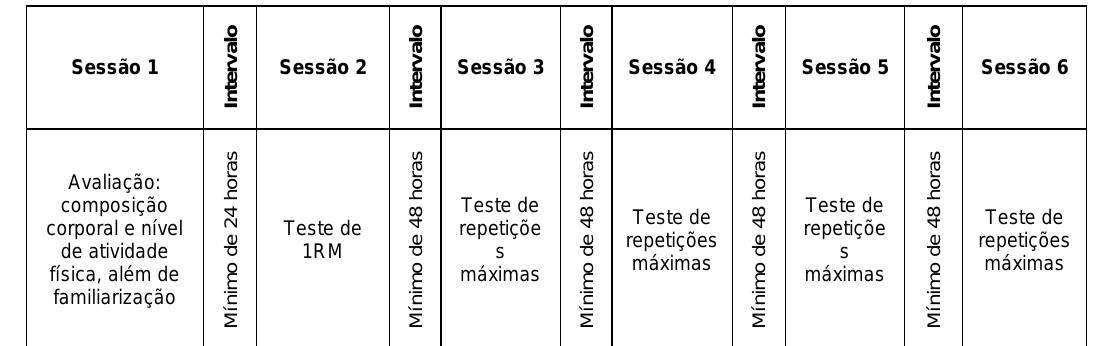
Figura. 1- Desenho Experimental